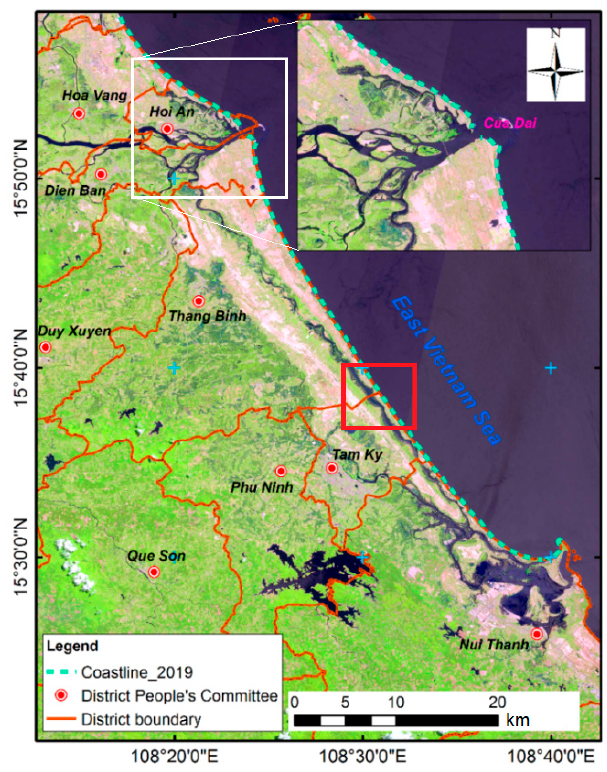
Figure 7. ( a ) An example of producing the WFI map and ( b ) annual land–water classification map in the northern part of Cua Dai estuary in 2019.